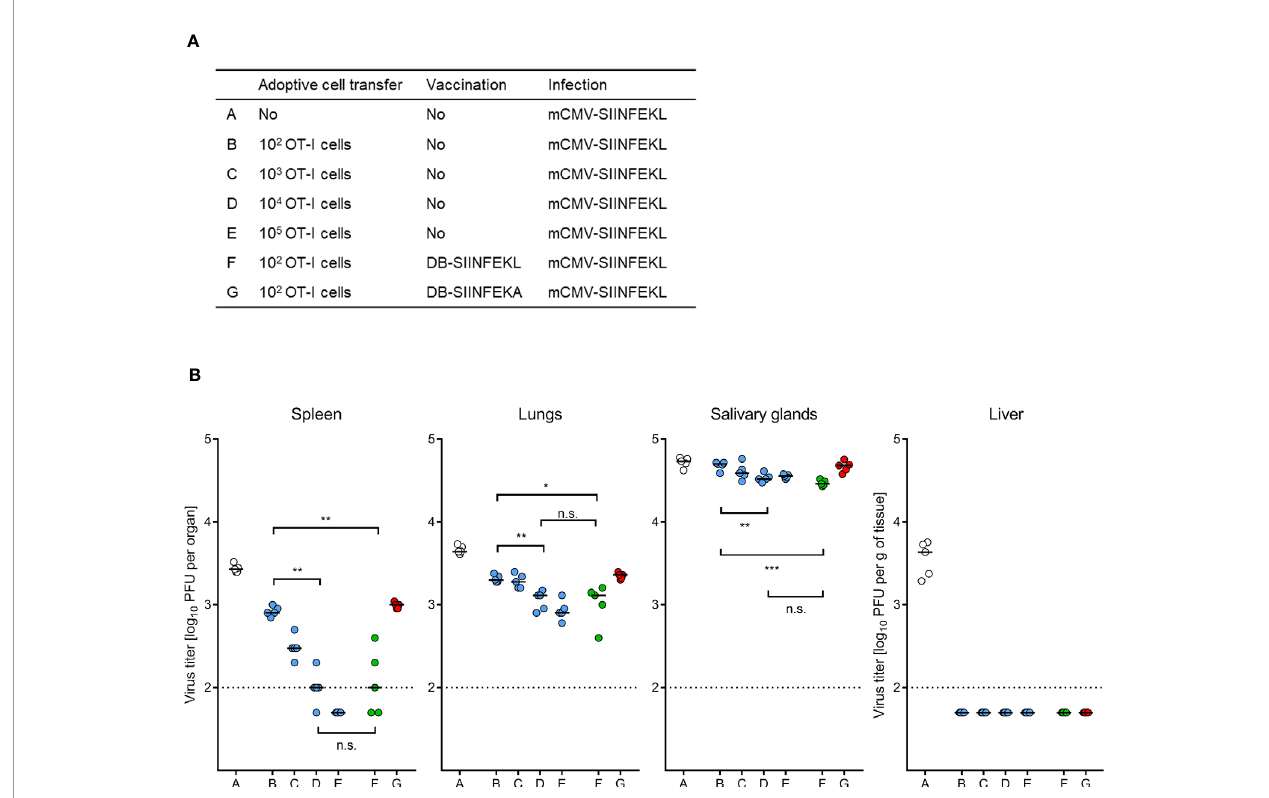
FIGURE 12 | ACT dose-bene fi t from TherVac in HCT recipients. (A) Table of experimental groups A – G. For the protocol, see the sketch in Figure 11A, with the modi fi cation that ACTs alone were performed with graded numbers of OT-I cells. Organ infection was assessed on day 14 after infection with mCMV-SIINFEKL. (B) Virus titers in organs indicated. Symbols (open circles: no ACT, blue closed circles: ACT alone, green closed circles: ACT and TherVac with DB-SIINFEKL, red closed circles: ACT and control TherVac with DB-SIINFEKA) represent data from individually tested mice, with the median values marked. Signi fi cance levels (*) P < 0.05, (**) P < 0.01, (***) P < 0.001. (n.s.), not signi fi cant ( P > 0.05). Dotted lines, detection limit of the